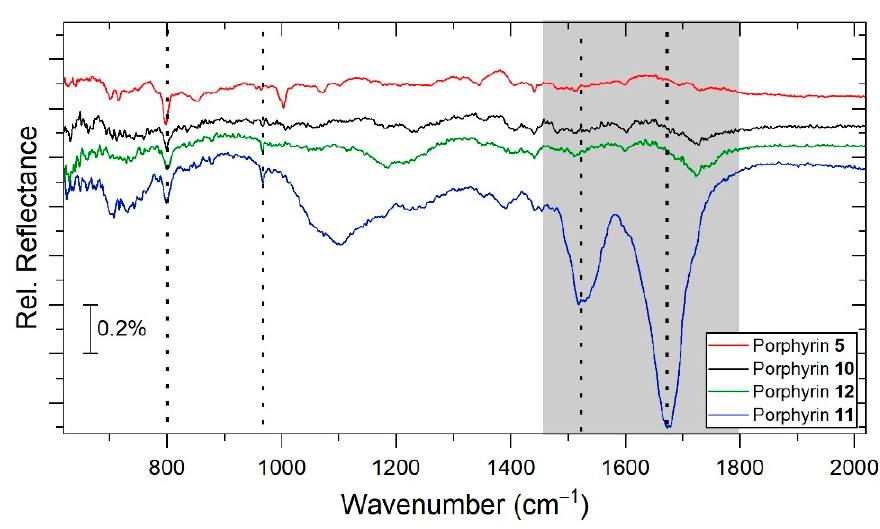
Figure 3. Infrared reflection-absorption (IRRA) spectra of different A 2 BC-type porphyrins on gold. The dashed line mark vibrational modes of the molecules. The grey marked region shows character- istic vibrational modes of the peptide chain.